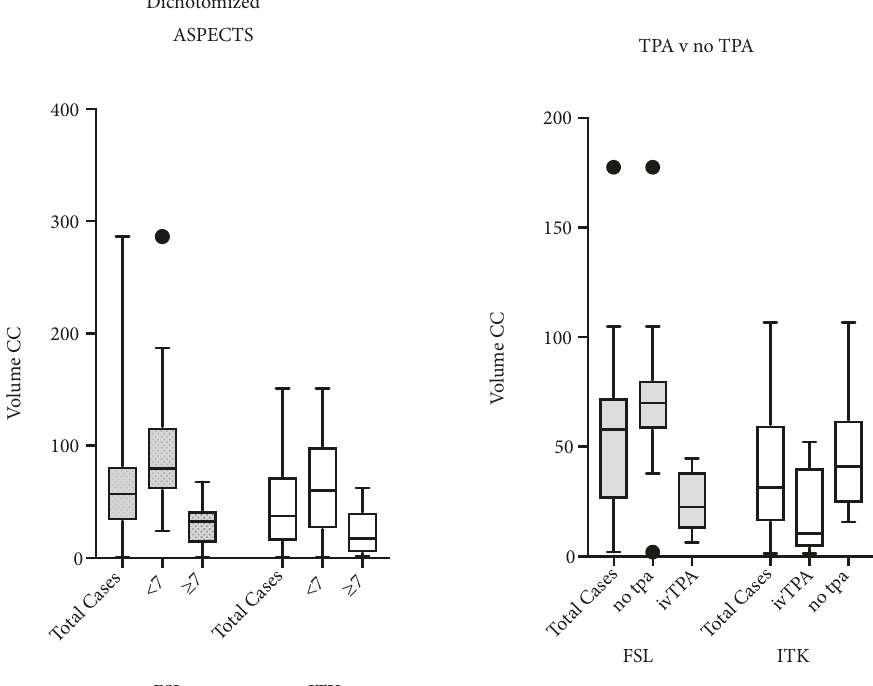
Figure5:BoxandwhiskersplotofcalculatedstrokevolumesasafunctionoftheIICprogramused(FSLorITK),correlatedwithdichotomized ASPECTS scores (left) and clinical decision to treat with IV TPA